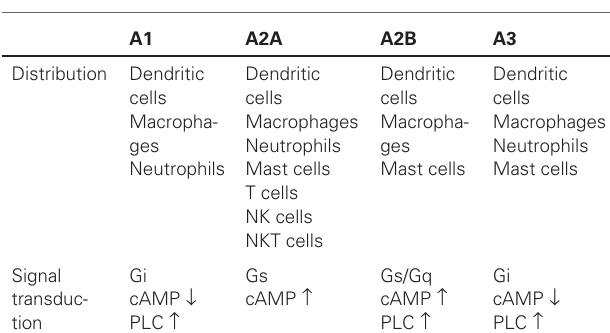
Table 1 | Adenosine receptor expression in immune cells and signaling